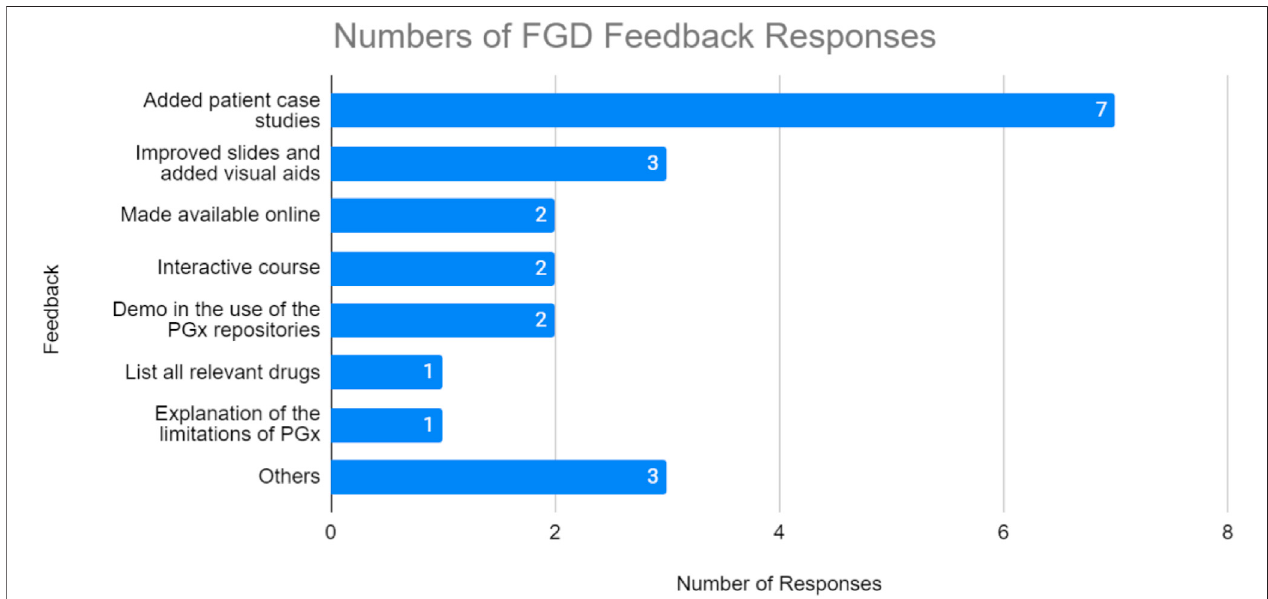
TABLE 4 | Participant characteristics in online TM2 training. Characteristics